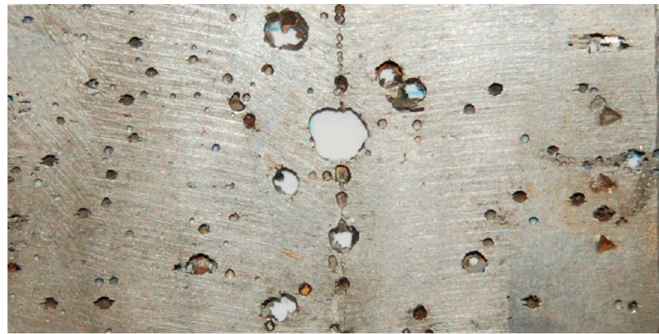
Figure 10. Pitting at the welding and HAZ zones of a 33% cold work sample.